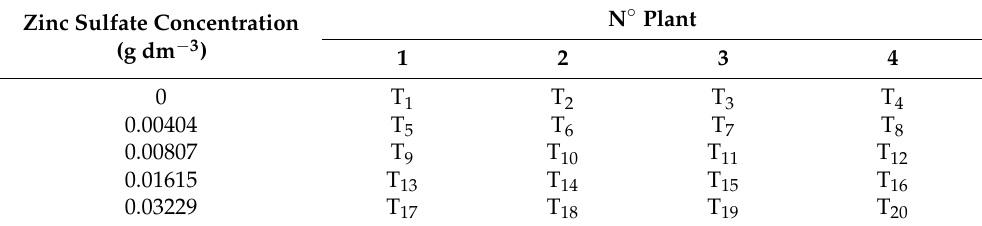
Table 6. Treatments by zinc concentrations.